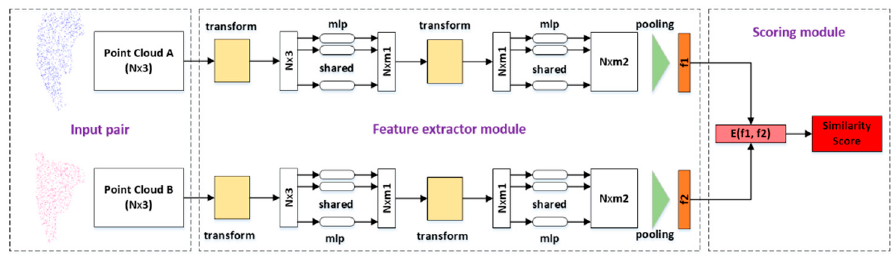
Figure 3. SiamesePointNet network architecture.